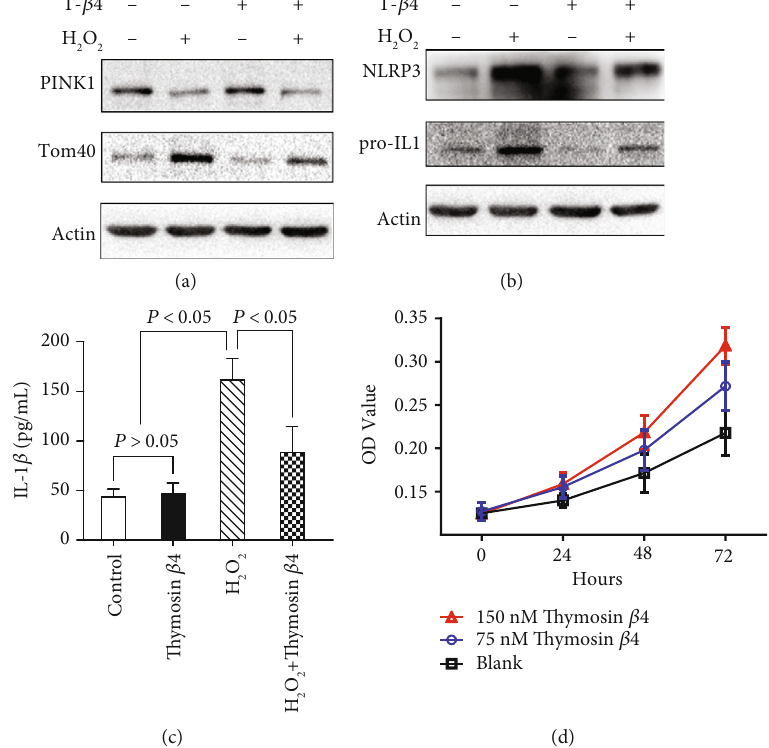
Figure 7: T β 4 reduces H O -induced inhibition of mitophagy and in fl ammasome activation and promotes proliferation in myocyte. 2 2 Western blot revealed the expression of PINK1 and Tom40 (a) and NLRP3 and IL-1 β (b) in myocytes treated by T β 4 (150nM, 4h) and/or H O (400 μ M). Secretion of IL-1 β in myocytes treated by T β 4 (150nM, 4h) and/or H 2 2 myocytes treated by T β 4 (75-150nM, 12h)